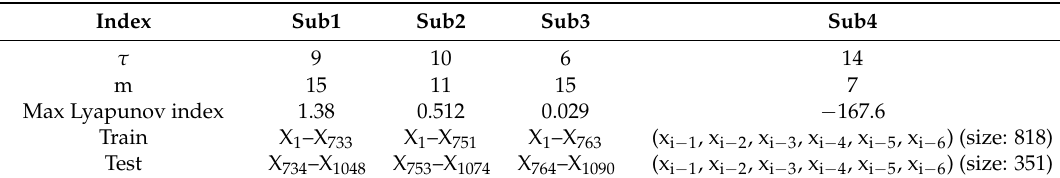
Figure 8. ( a ) The result of the partial autocorrelation function (PACF) analysis of sub4 after processing by FEEMD of the Beijing carbon price; ( b ) The result of the PACF analysis of sub5 after processing by FEEMD of the Beijing carbon price.